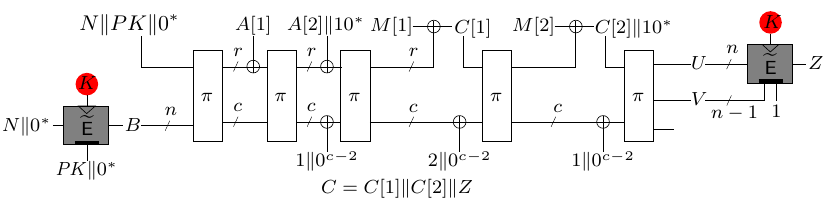
Figure 6: TETSponge [ π, e E ] K,PK AEAD for ν = 2 blocks of associated data and ‘ = 2 message blocks. Dark squares indicate the “leak-free” TBC where the triangle denotes the key input and the small black rectangle denotes the tweak input. The value 1 k 0 c − 2 is inserted only if | A [ ν ] | < r , resp. | M [ ‘ ] | < r